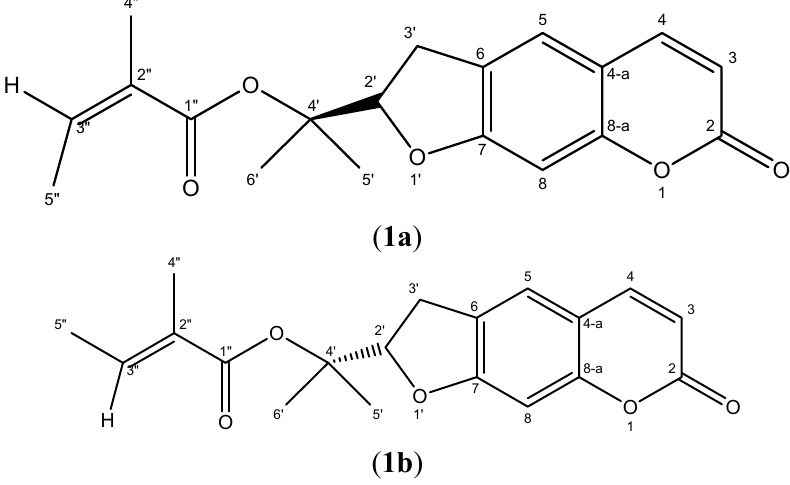
Figure 1. Structure of (+)- Z -deltoin ( 1a , major compound) and ( − )- E -deltoin ( 1b , minor compound).